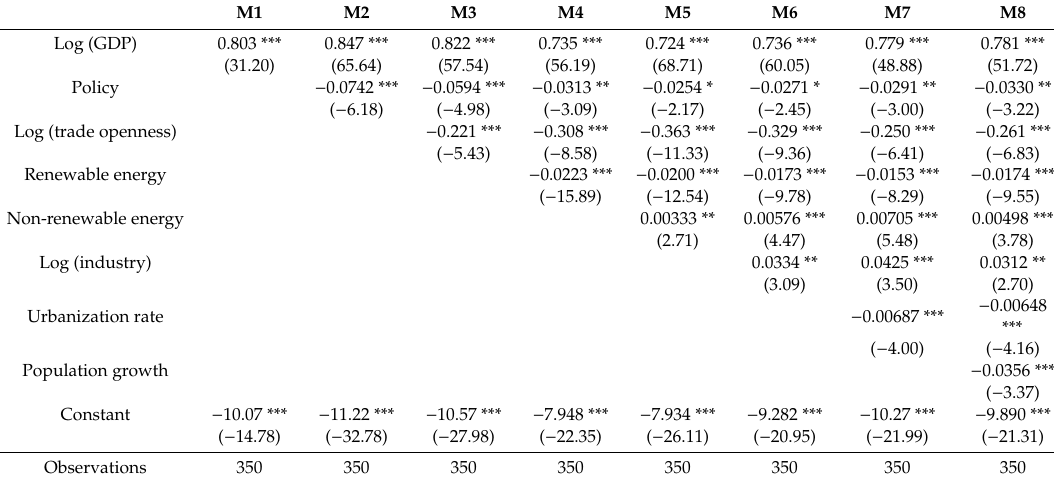
Table 6. Relationship between CO 2 emissions and GDP, with control variables in the high-income countries (HIC).